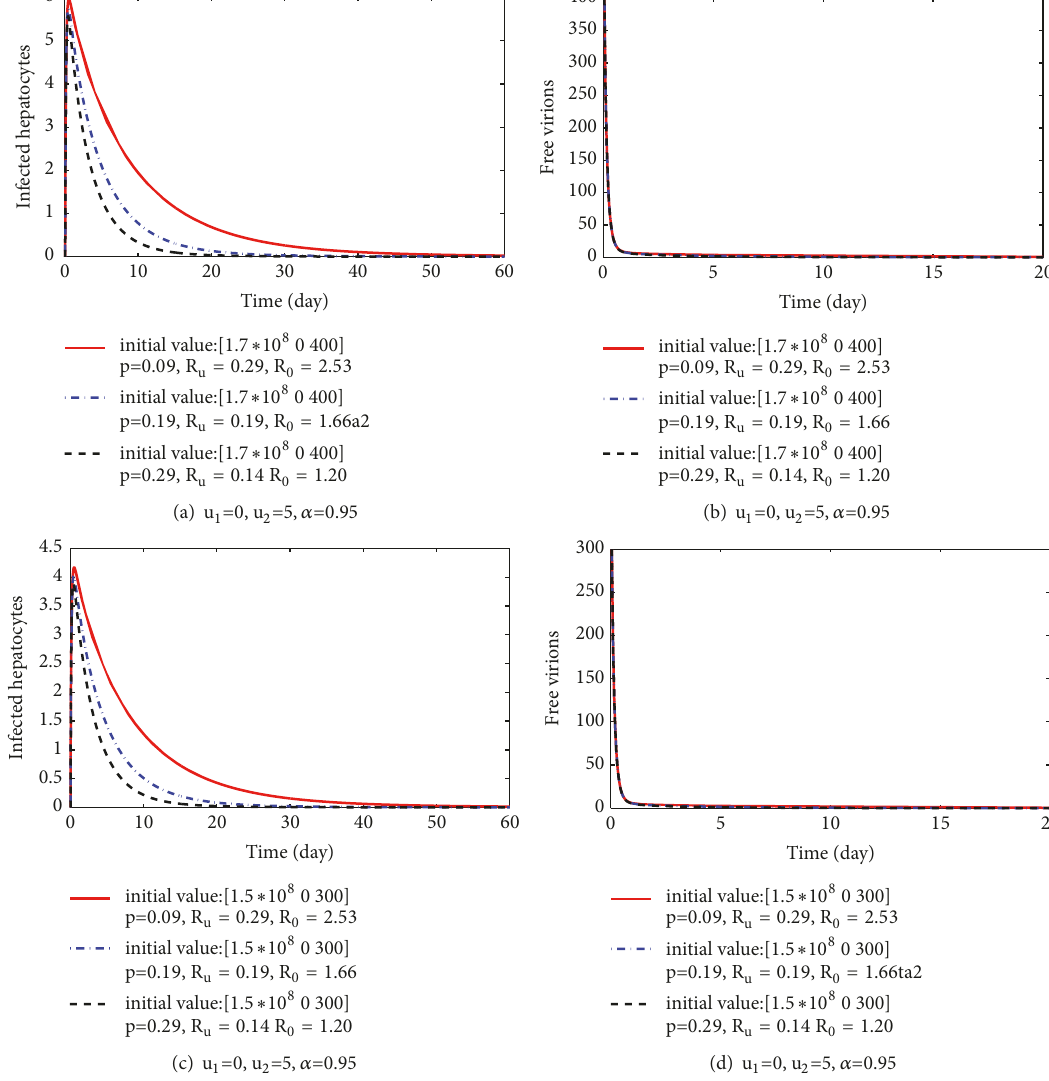
Figure 3: In this case, only LAM(without IFN) is used to treat HBV. For different values of 𝑝 , when 𝑅 𝑢 < 1 < 𝑅 0 , the disease-free equilibrium 𝐸 0 = (Π/𝛿, 0, 0) = (1.667 × 10 8 ,0,0) is asymptotically stable.The initial conditions of (a) and (b) are as follows: [ 1.7 × 10 8 0 400]; the initial 𝑢 conditions of (c) and (d) are as follows: [ 1.5 × 10 8 0